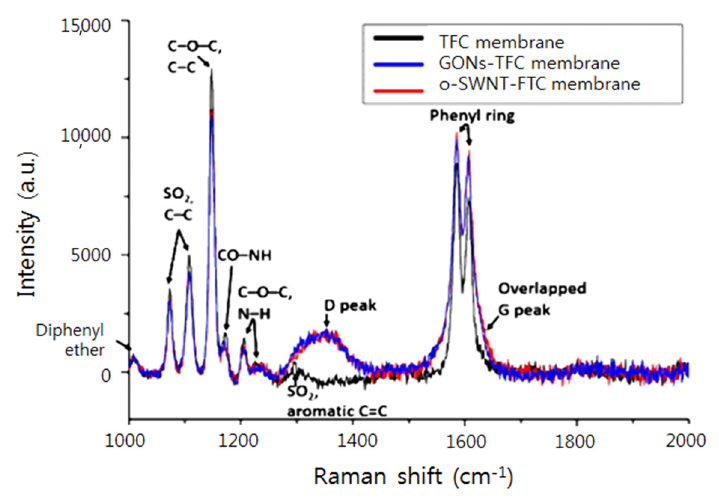
Figure 2. Raman spectra of TFC (black line), GONs-TFC (blue line), and o-SWNTs-TFC (red line) membranes.